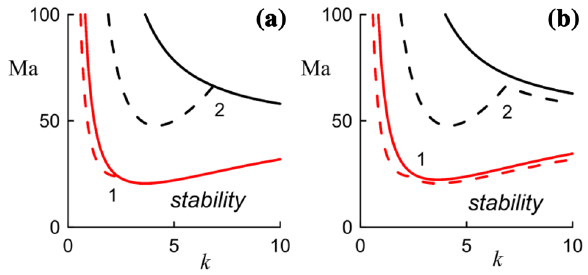
Fig. 2 Neutral stability curves for the monotonic (solid lines) and the oscillatory (dashed lines) longwave modes in case of a a pure liquid and b liquid layer covered by insoluble surfactant, N = 0 . 001, Le = 0 . 003. Lines 1 and 2 correspond to βC = 10 and 100, respec- tively. Here Ga = 10. The domain of stability is located below every line